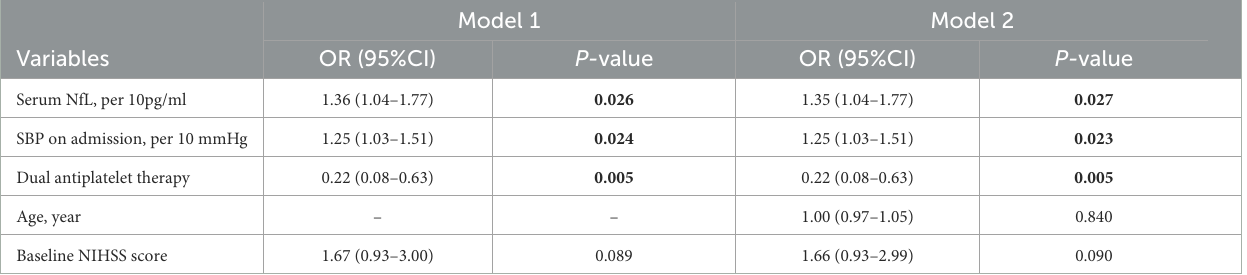
TABLE 3 Multivariate analyses for factors associated with END in patients with MIS.